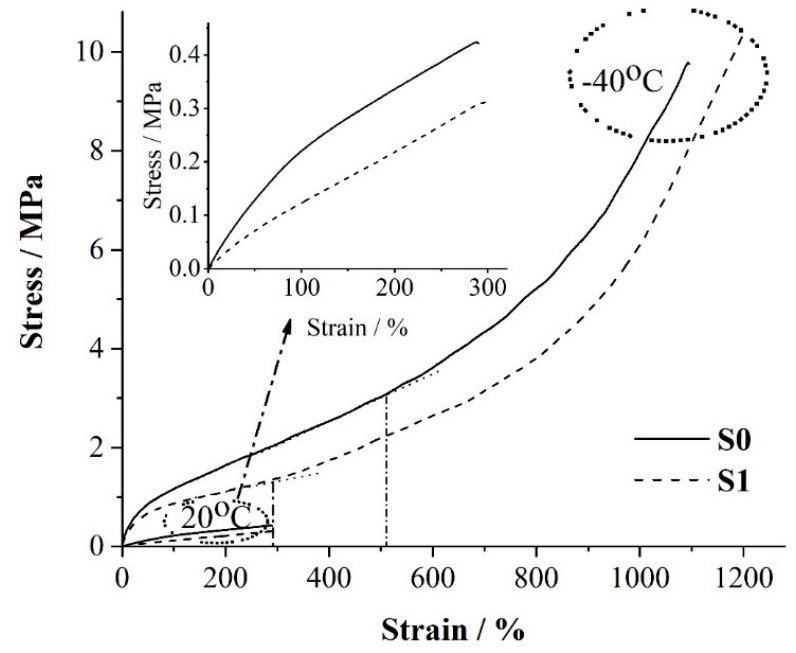
Figure 5. Stress–strain curves of elastomers.